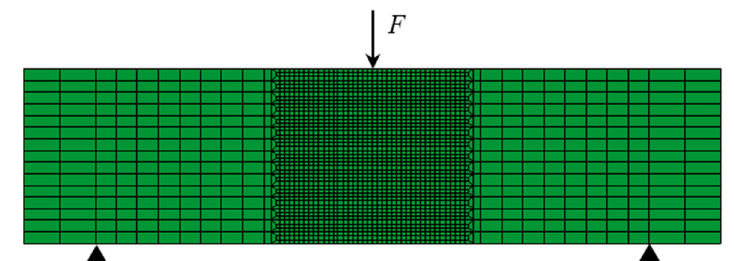
Figure 15. Three-point bending model for the finite element simulation.